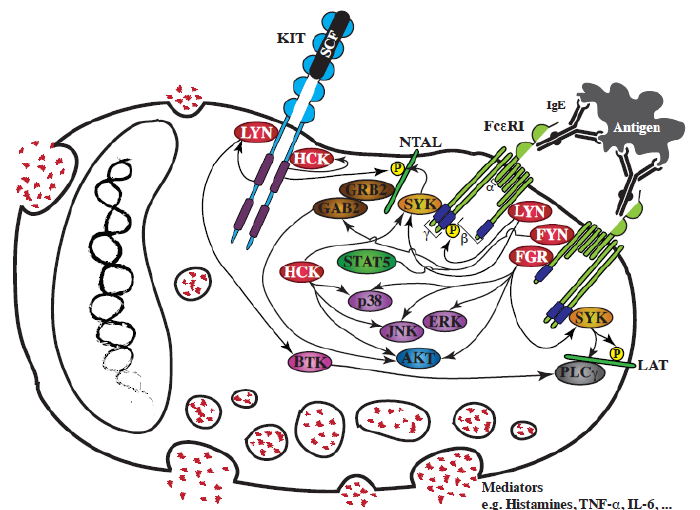
Schematic representation of the involvement of SFKs in Fc ε RI-mediated mast cell degranulation and in the interplay between KIT and Fc ε RI. Following SCF binding to the extracellular region of KIT, or Fc ε RI aggregation by antigen, a rapid activation of SFKs, LYN, FYN, HCK and FGR, is observed. Fc ε RI signaling regulates the degranulation of mast cell mediators stored in intracellular granules. KIT signaling synergizes with the Fc ε RI response by increasing SFK activation, which fuels several pathways activated downstream of Fc ε RI.